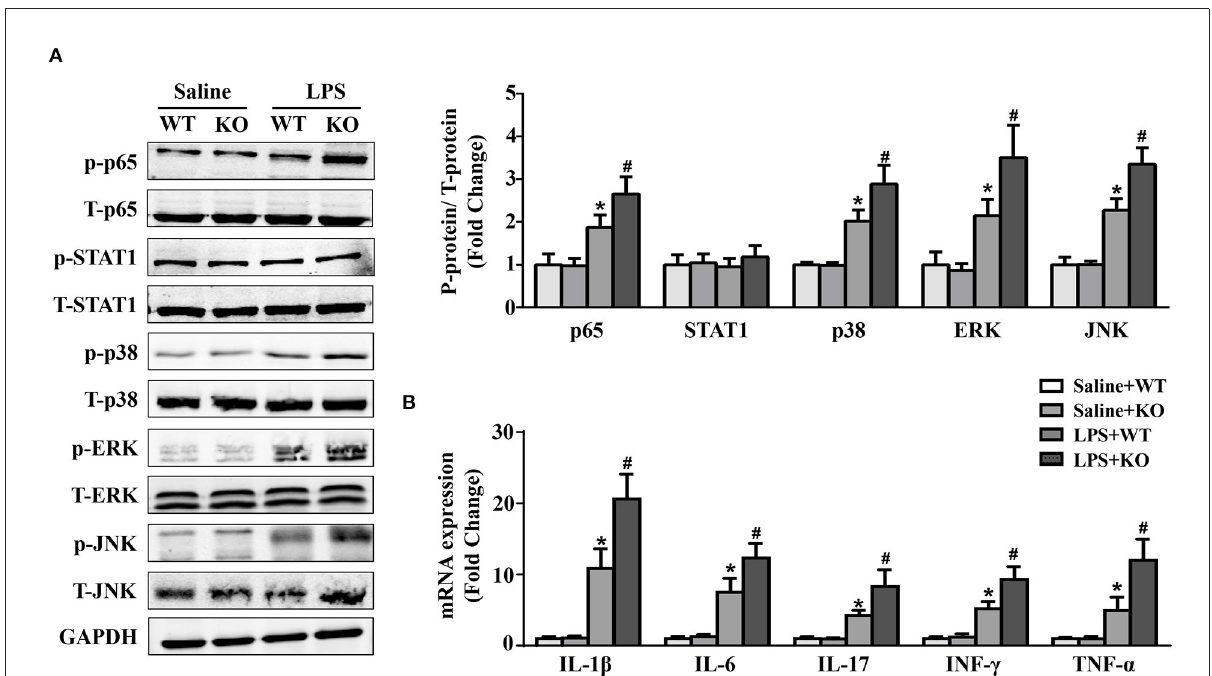
FIGURE3 IL-12p40 deletion increases the phosphorylation of NF- κ B and MAPK signaling pathways and aggravates cardiac inflammation in mice treated with LPS. (A) Western blot analysis of T-ERK, p-ERK, T-p38, p-p38, T-JNK, p-JNK, T-STAT1, p-STAT1, T-P65, and p-P65 protein levels in the hearts of mice and the ratios of p-ERK/T-ERK, p-p38/ T-p38, p-JNK/T-JNK, p-P65/T-P65, and p-STAT1/T-STAT1 in each group ( n = 5). (B) qRT-PCR analysis of IL-1 β , IL-6, IL-17, TNF- α and INF- γ mRNA expression levels in the hearts of mice in each group ( n = 6). * P < 0.05 compared with the Saline group. # P < 0.05 compared with the LPS + WT